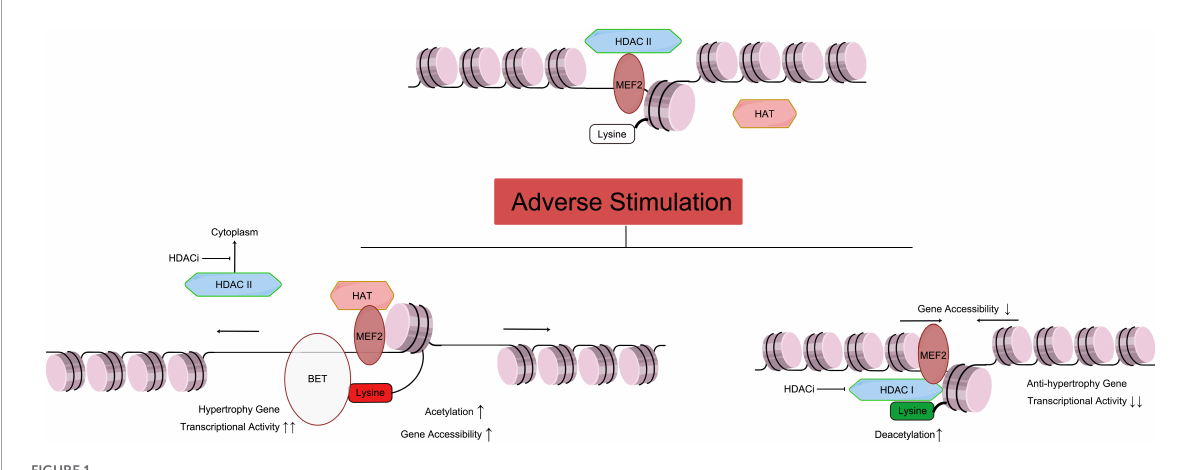
FIGURE1 Relationship of HAT and HDAC mediated histone acetylation/deacetylation leading to cardiac hypertrophy. As mentioned above, the Class IIa HDACs are not capable of deacetylating histone residues due to a within the catalytic domain mutation. Therefore, HDAC IIa represses gene transcription by binding with MEF2, recruiting other transcriptional repressors and epigenetic regulators to DNA promoter regions, and maintaining the acetylation level of histone ( Figure 1 top part). Under adverse stimulation such as pressure overload, HDAC IIa isolate from MEF2 and transport to cytoplasm, while MEF2 recruiting HAT and catalyze histone lysine residue, and regulate transcription activity. Meanwhile, BET family recognize the acetylation of histone, and bind to related gene promoter region, and promote cardiac hypertrophy ( Figure 1 left bottom part). Meanwhile, Class I and IIb HDACs catalyze the removal of acetyl groups from key lysine residues within histone. Histone deacetylation induces chromatin condensation, which represses gene transcription by making gene promoter and enhancer regions less accessible to transcription. Overexpression of HDAC I reduces acetylation of lysine in histone (such as H3K27ac), which will reduce anti-hypertrophy gene transcriptional activity, leading to cardiac hypertrophy. HDACi can inhibit HDAC I catalyze activity, and stop the